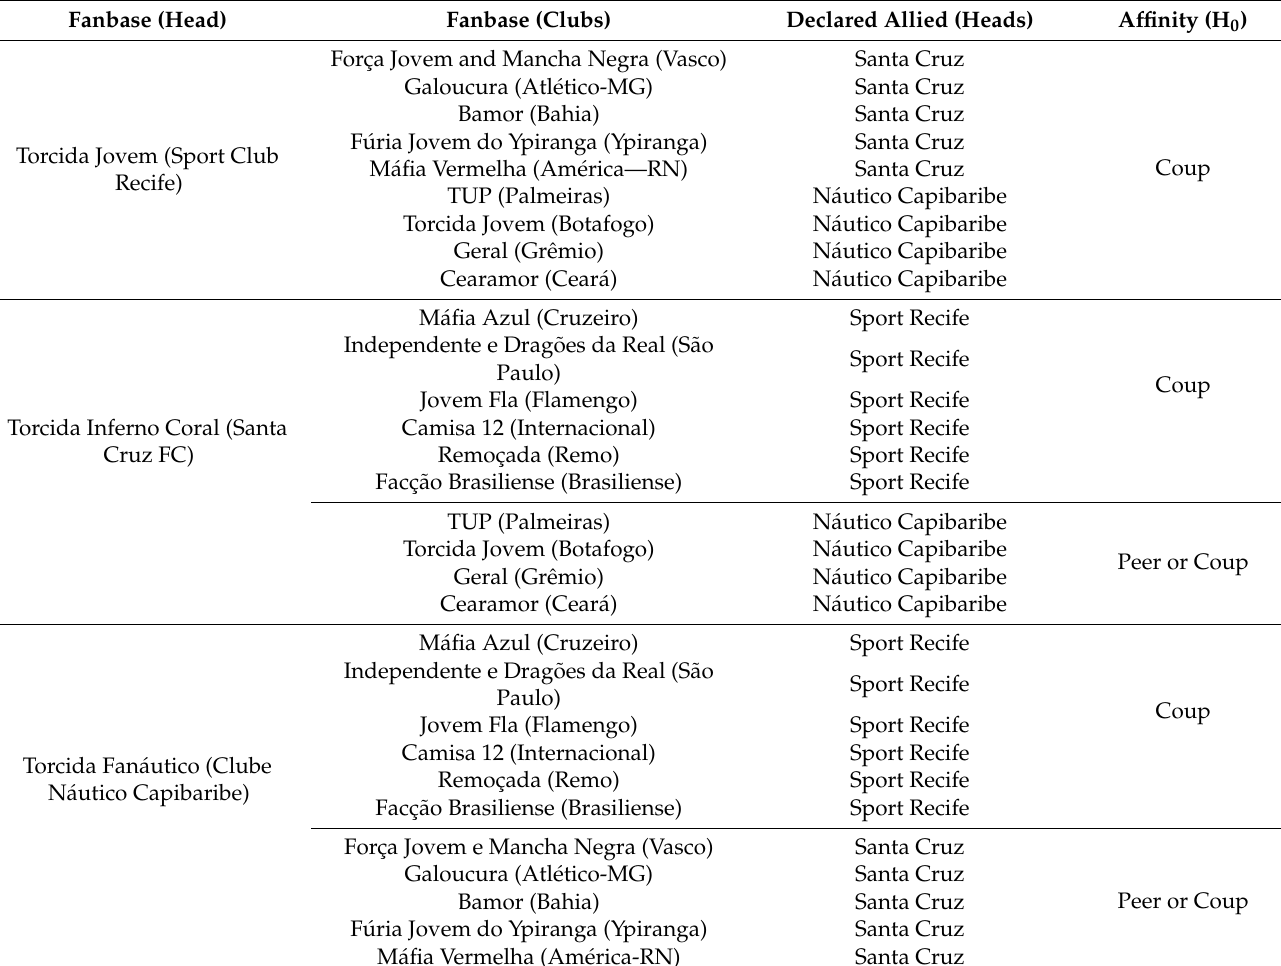
Table A1. Set of declared enemies and friends for each head gang (Torcidas Organizadas).